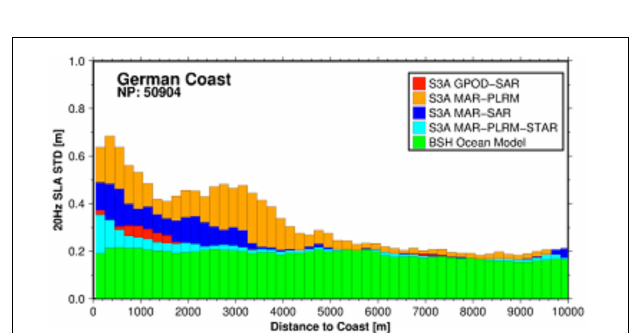
FIGURE 6 | Sea level anomaly at 20 Hz standard deviation in 200 m bins of distance to coast for different Sentinel-3A processors and the BSH model along the German coast. The Sentinel-3A SAR altimetry processed with SAMOSA+ at the Grid Processing On Demand (GPOD) service at ESRIN exhibit the smallest standard deviation (adapted from Fenoglio et al., 2019, with